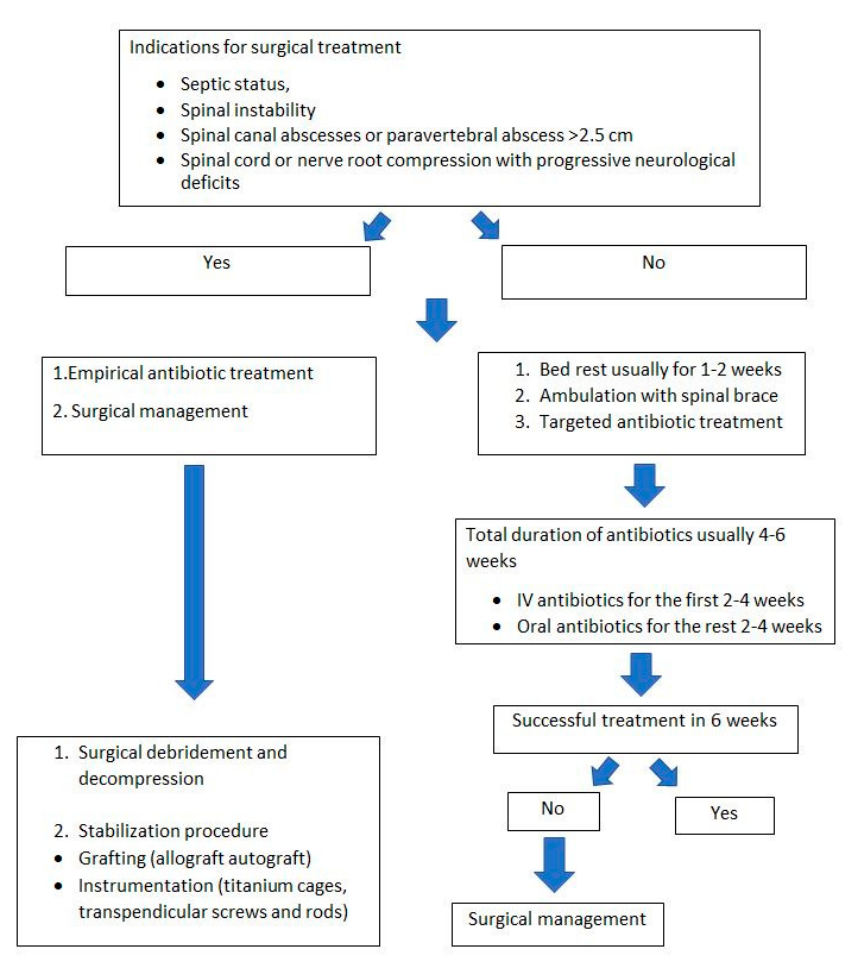
Figure 6. Treatment algorithm for spinal infections.